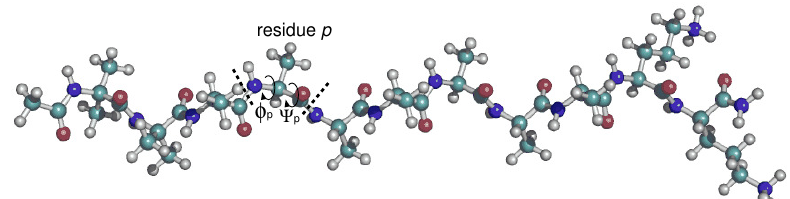
Figure 1. The 11-residue peptide X 2 A 7 O 2 peptide (XAO), where X, A, and O denote diaminobutyric acid, alanine, and ornithine, respectively, contains seven consecutive alanine